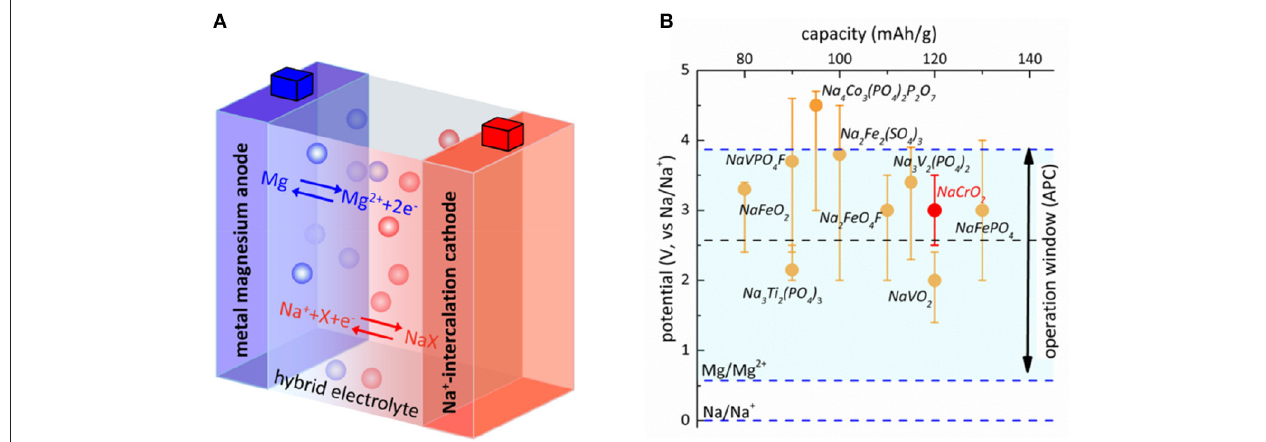
FIGURE 1 | Design of Mg-Na hybrid battery. (A) Illustration of working principle of Mg-Na hybrid cell. (B) Align the window of stability of Mg-APC (blue dashed line) and Mg(BH 4 ) 2 (black dashed line) and the operating range of voltage for several Na-battery